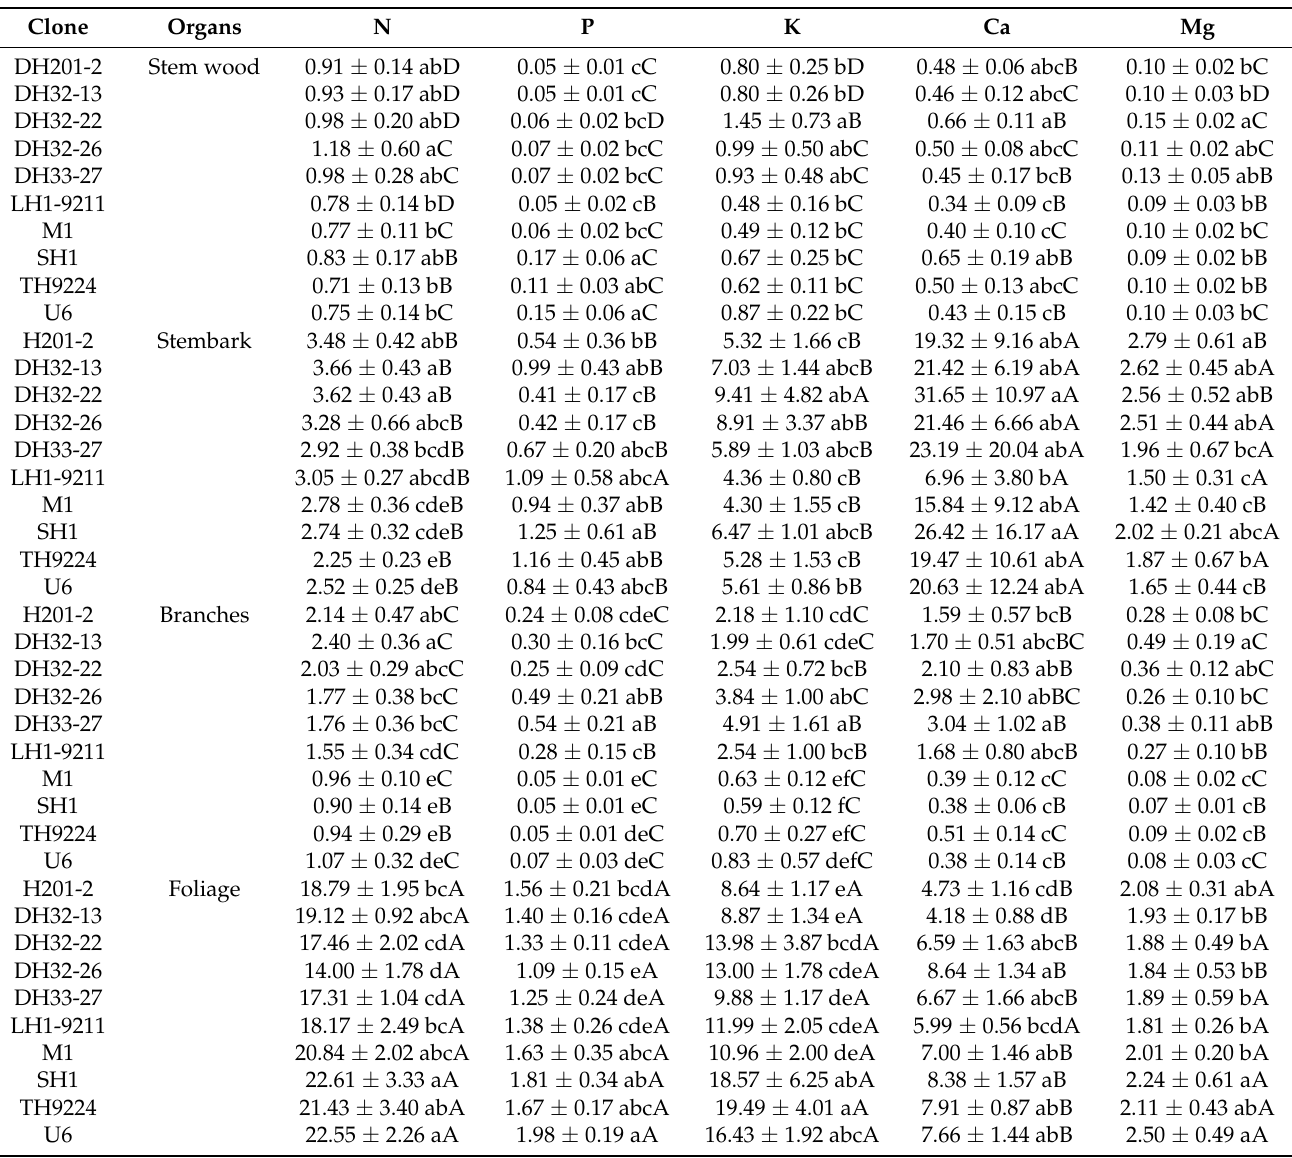
Table 3. Mean concentrations ± S.D. (g · kg − 1 ) of major nutrients in different tree components in ten Eucalyptus